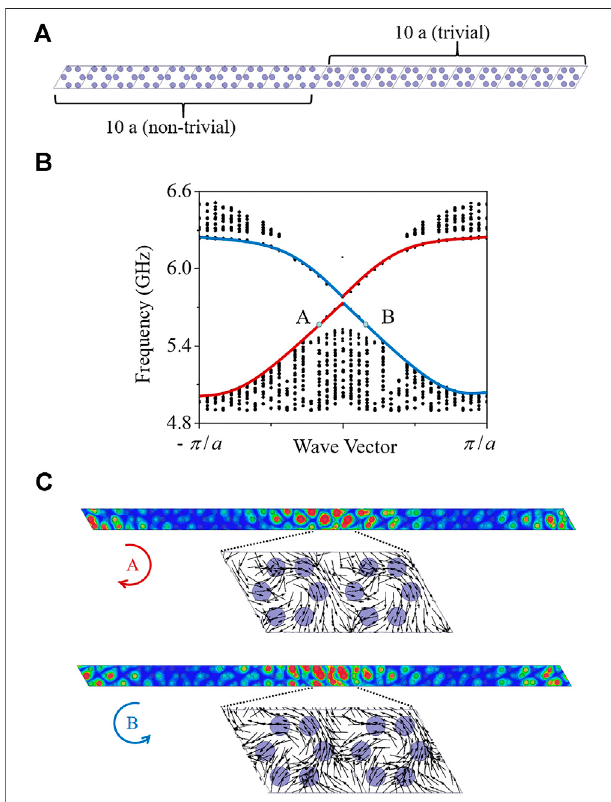
FIGURE 3 | (A) Multi-cell con fi guration consists of two parts with 10 topologicallynon-triviallatticesontheleftand 10topologicallytriviallattices on the right. (B) Band structure ofthe multi-cell con fi guration, where theblue and red lines represent the edge states. It can be seen that there are two different pseudo-spin modes at the interface. Red indicates clockwise and blue is anticlockwise. (C) Electric fi eld distributions of the multi-cell con fi guration. The direction of pseudo-spin modes corresponding to A and B in Figure 3B . The color represents the electric fi eld intensity, and the arrows represent the direction of the time-averaged energy fl